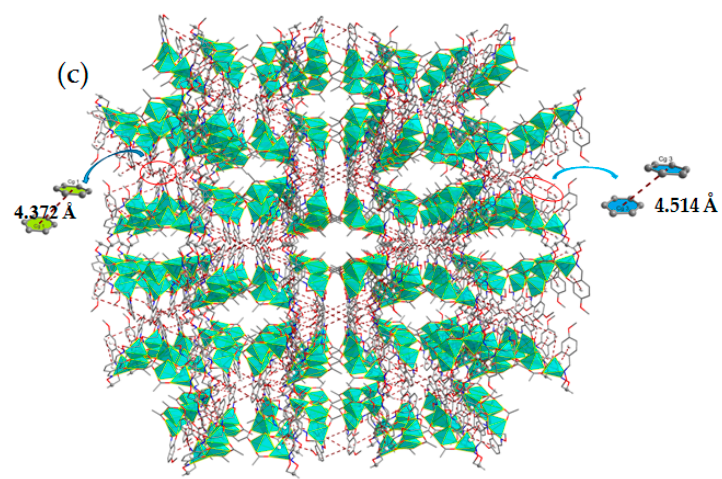
Figure 4. ( a ) Intra-molecular hydrogen bondings of the Zn II coordination compound unit (hydrogen atoms, except those forming hydrogen bonds, are omitted for clarity); ( b ) One-dimensional supra-molecular structure of the Zn II coordination compound, mediated by inter-molecular C-H ∙∙∙π (pink) interactions; ( c ) 3-D supramolecular structure of the Zn II coordination compound, mediated by intermolecular C-H ∙∙∙π and π∙∙∙π interactions.